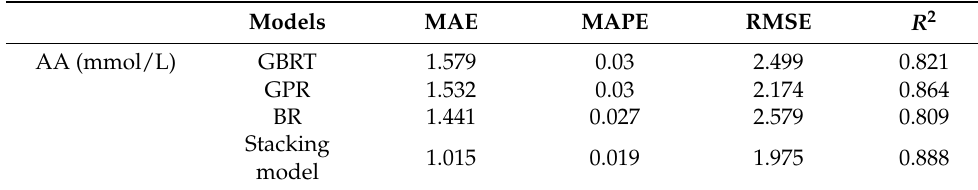
Table 3. Comparison of the acetic acid (AA) prediction performances of different models.